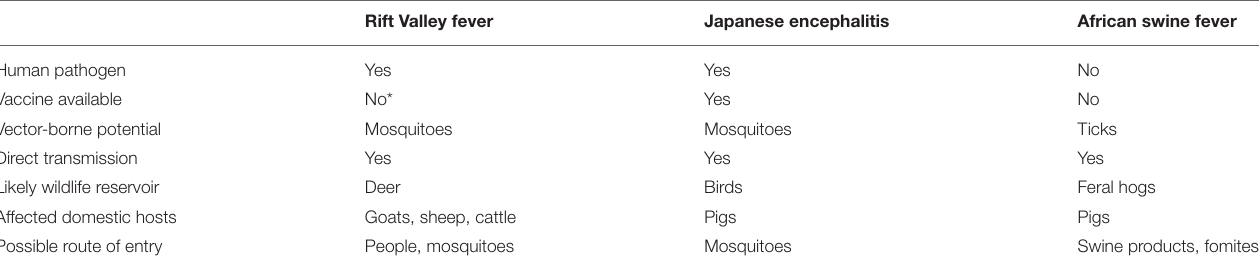
TABLE 1 | Similarities and differences among the invasion and establishment of Rift Valley fever virus, Japanese encephalitis virus, and African swine fever virus into the United